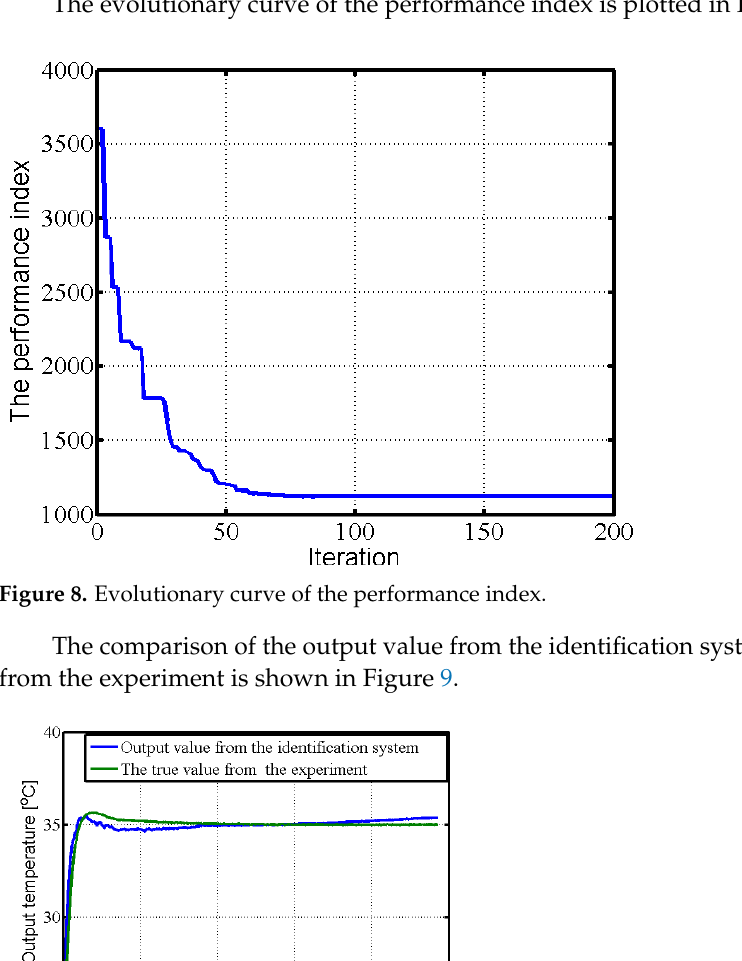
Figure 7. Evolutionary curve of the estimation of q 1 . The evolutionary curve of the performance index is plotted in Figure 8.